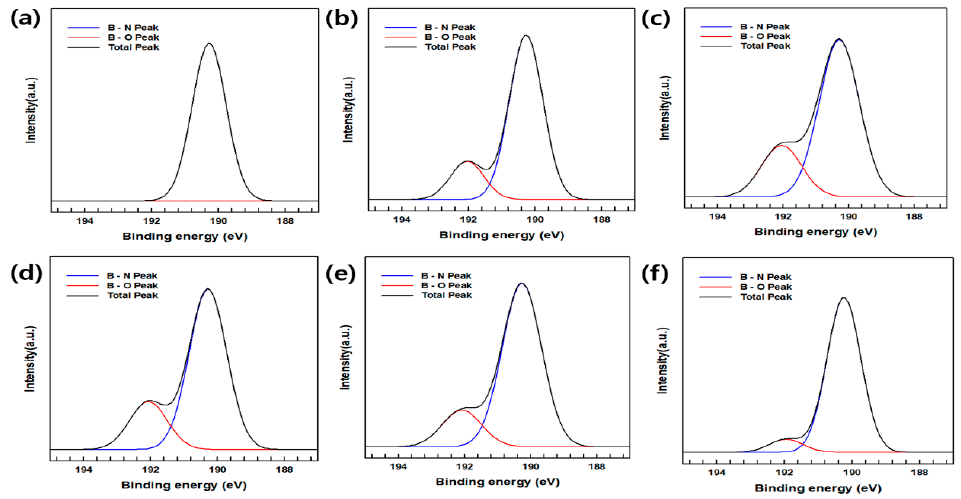
Figure 2. XPS B1s peak of raw BN ( a ), BN–OH ( b ), BNNs–A ( c ), BNNs–B ( d ), BNNs–C ( e ), and BNNs–D ( f ).